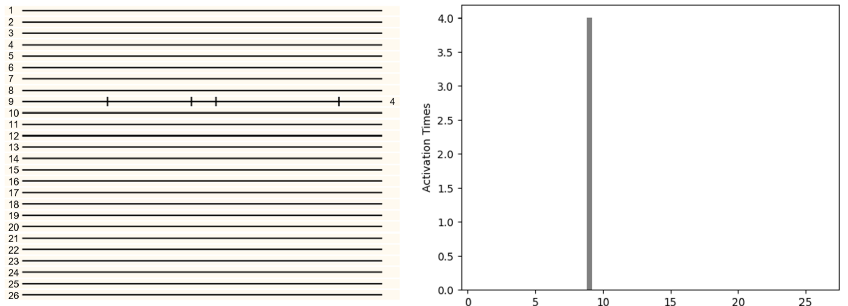
Figure 10. The neuron activation diagram in the twenty-six direction caused by the motion of the 4-voxel random-dot object in the three dimensional space ( left ). Each line represents 26 directions, each point on the line represents the detection neuron, and each stimulation on the line represents that the neuron at this point is activated. The number of activations is represented by a histogram ( right ). The number of activations of neurons in all directions is displayed on the histogram. The 1st-direction neurons have the highest number of activations. It can be inferred that the object moves in the 1st direction.